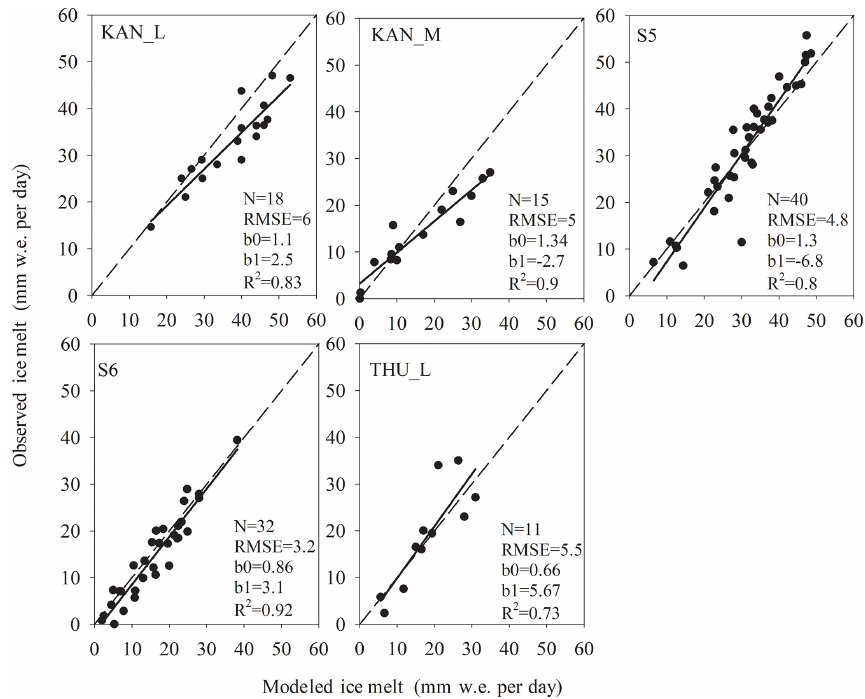
Figure 5. Average 10d modeled and observed ice melt (expressed in mmw.e. per day) for the five AWSs situated in the ablation zone, assuming an ice density of 910kgm − 3 . The dashed line is the 1 : 1 line and the solid line the linear regression line. Statistics show the number of data points ( N ), root mean square error (RMSE), regression slope ( b 0 ) and intercept ( b 1 ), and coefficient of determination ( R 2 ).